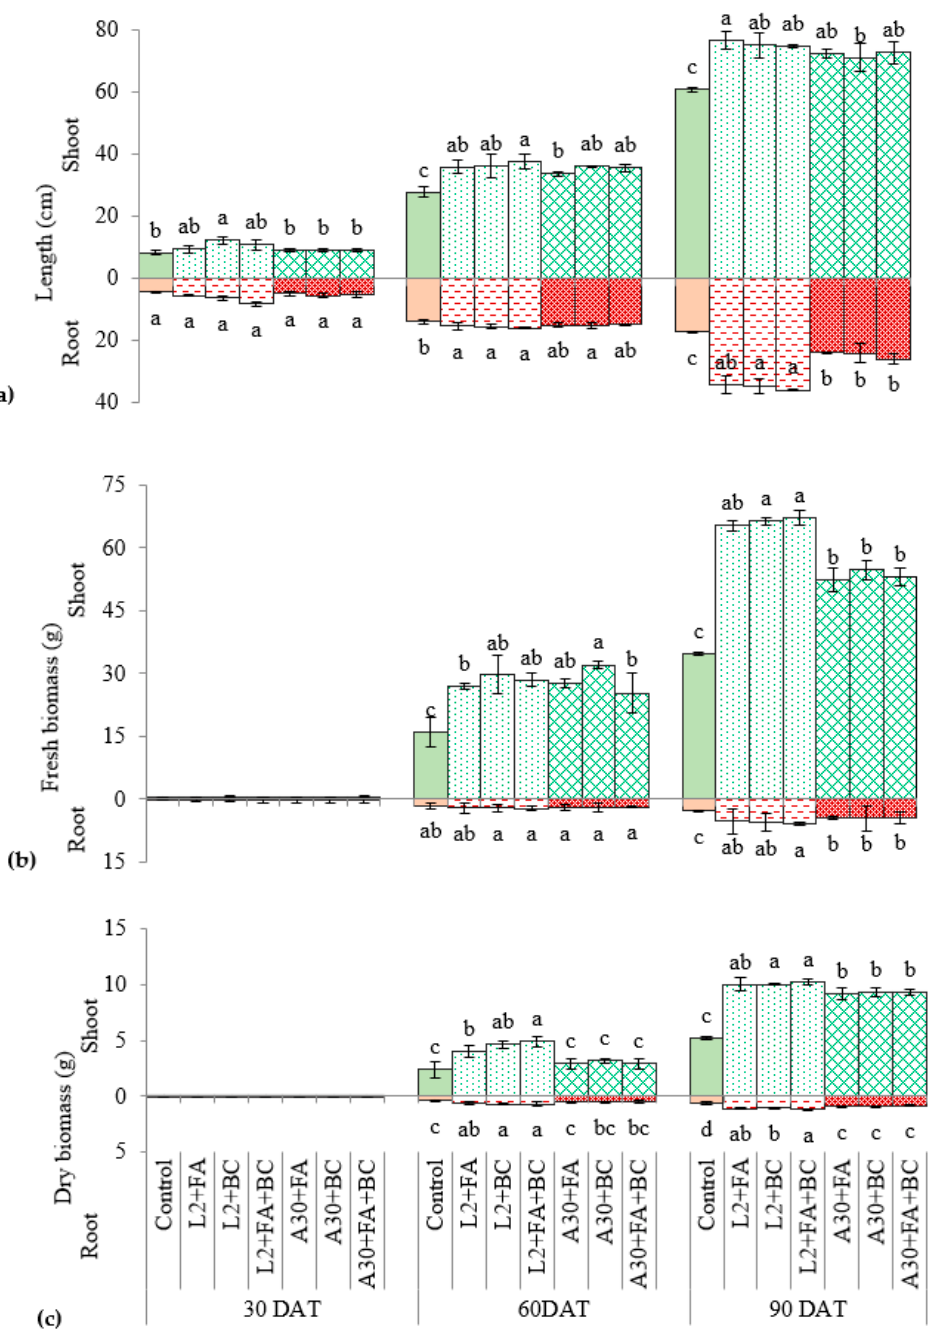
Figure 2. Influence of biofertilizers prepared using strain L2 and A30 on biometric growth parameters of eggplant root and shoot: ( a ) length (cm), ( b ) fresh wt. (g), and ( c ) dry wt. (g), at the end of the pot experiment at an interval of 30 days till 3 months after transplantation (DAT) (Mean ± SD; n = 4). Different alphabetical letters represent a significant difference at p < 0.05 for the same DAT and parameters. No significant difference at 30 DAT for root and shoot fresh and dry weight was observed.